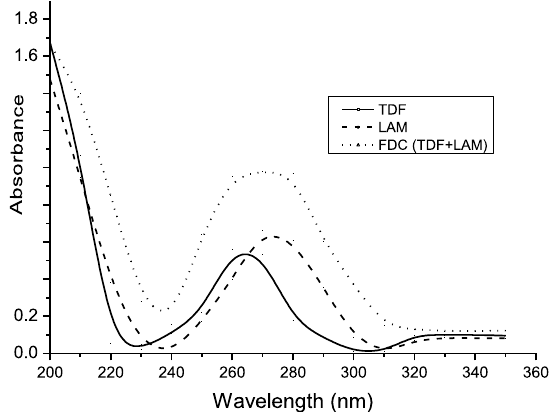
Fig. 2 Zero-order derivative spectra for TDF, LAM, and mixture